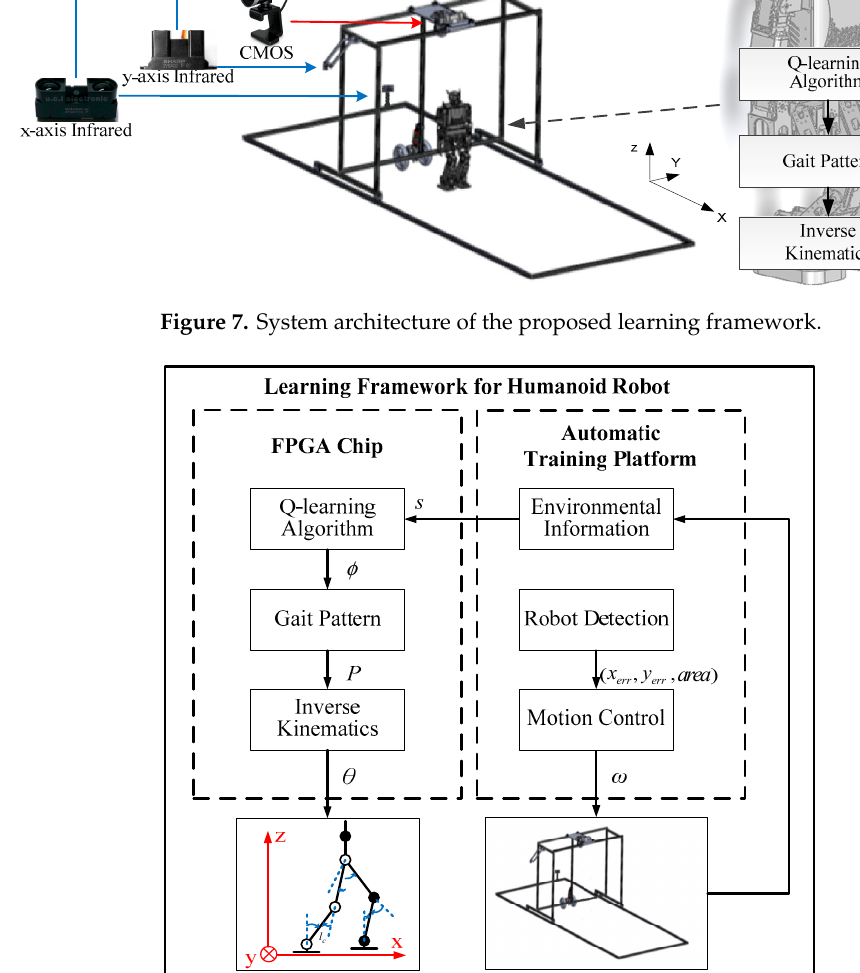
Figure 8. System diagram of the proposed learning framework.